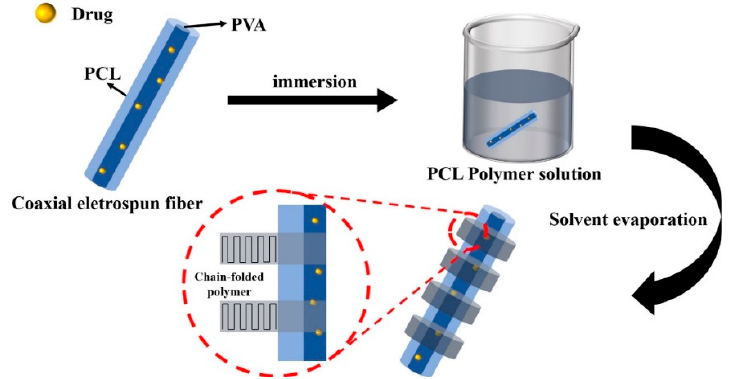
Figure 13. Illustration of the fabrication of the PCL/polyvinyl alcohol (PVA) shish-kebab-structured scaffolds. Reproduced with permission [67]. Copyright © 2021, American Chemical Society.